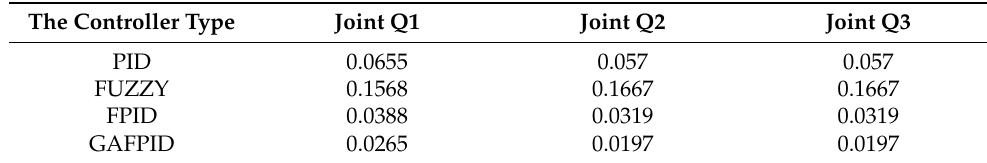
The Controller Type